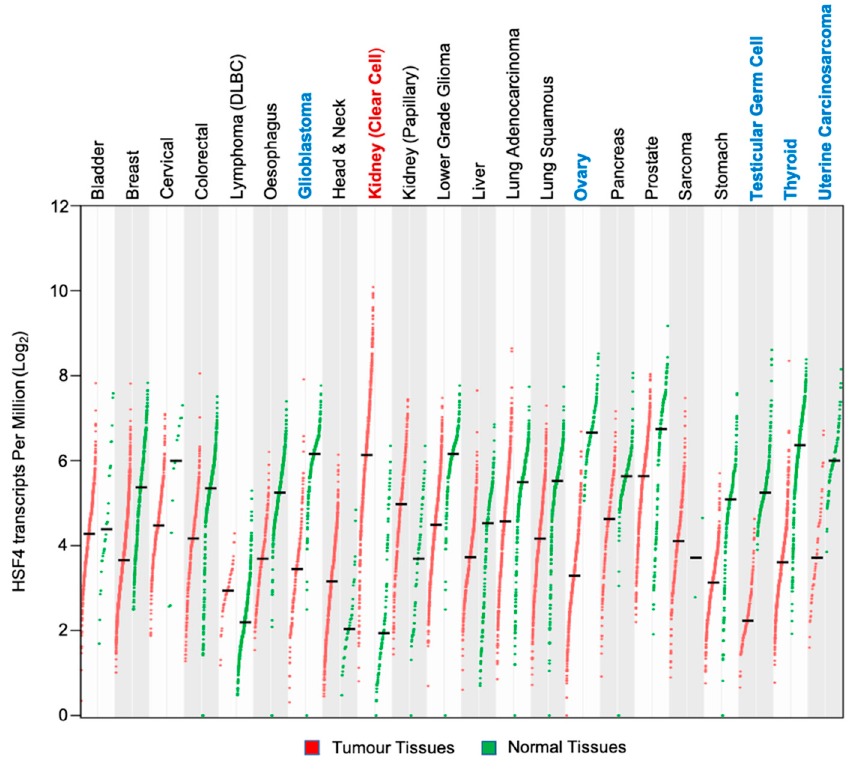
Figure 7. Dot plots representing the HSF4 expression RNA-Seq data in tumor and normal tissue samples from The Cancer Genome Atlas (TCGA) and The Genotype-Tissue Expression (GTEx) databases, respectively. HSF4 was found to be significantly upregulated in clear cell renal cell carcinoma (ccRCC) and significantly downregulated in glioblastoma, ovarian cancer, testicular germ cell cancer, thyroid cancer and uterine carcinosarcoma (Log2FC|2|; p -value < 0.05). The data were analyzed and visualized using the GEPIA2 (Gene Expression Profiling Interactive Analysis) web application (http://gepia.cancer-pku.cn, accessed on 9 January 2021).